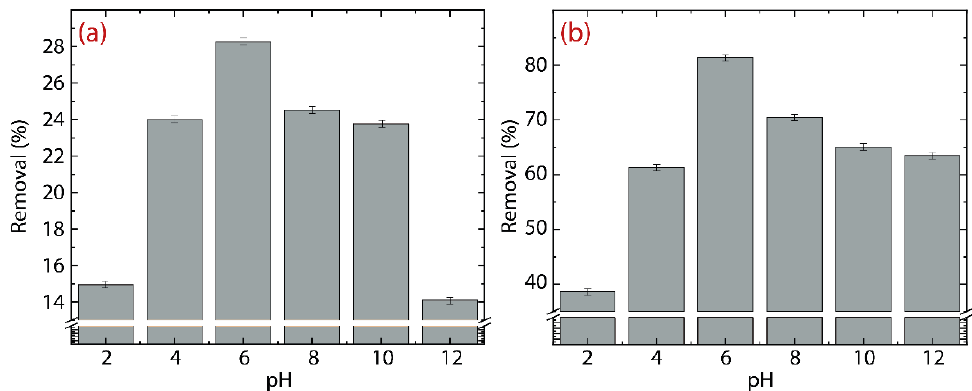
Figure 6. Adsorption of Hg(II) as a function of the initial pH on ( a ) GO and ( b ) rGO. The initial concentration is 150 mg L −1 .